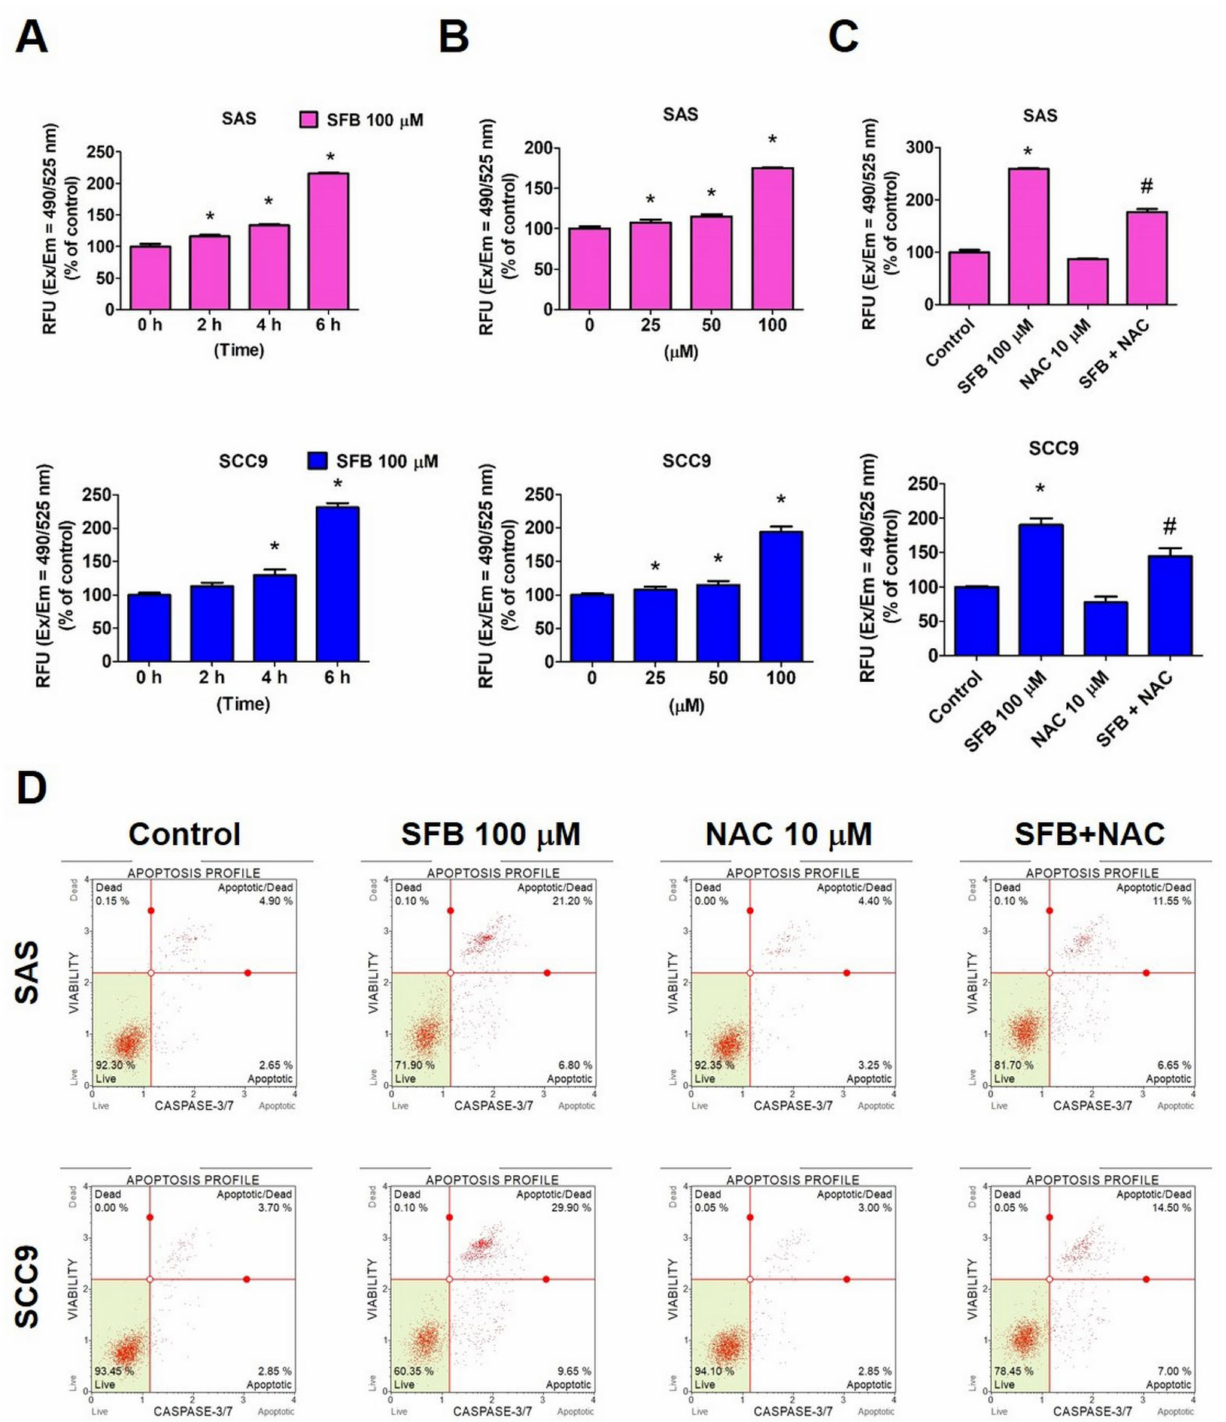
Figure 5. Semilicoisoflavone B induces apoptosis by ROS production in oral cancer cell lines. ( A ) After being treated with SFB (100 µ M) for 0, 2, 4, and 6 h, ROS assay was used by flow cytometry. ( B ) After being treated with SFB (0–100 µ M) for 6 h, ROS assay was used by flow cytometry. ( C ) After being treated with SFB (100 µ M) with/without NAC (ROS inhibitor, 10 µ M) for 6 h, the expression of ROS by flow cytometry was analyzed. ( D ) After being treated with SFB (100 µ M) with/without NAC for 6 h, the expression of apoptosis cells by flow cytometry was analyzed. Data are presented as mean ± SD ( n = 3). * p < 0.05, compared with the control group. # p < 0.05 compared with the SFB-only treatment